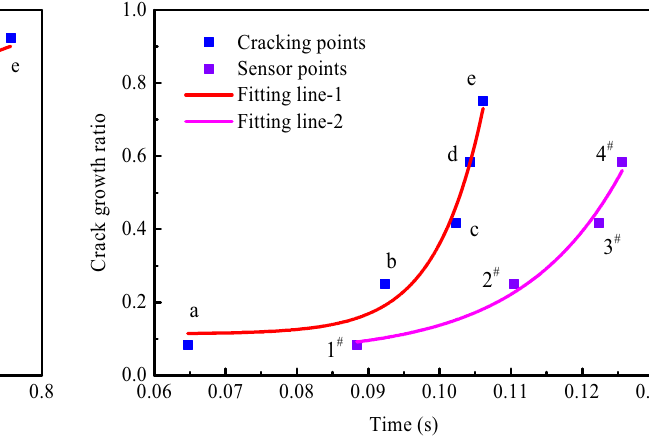
Figure 6: Cracking speed during propagation.